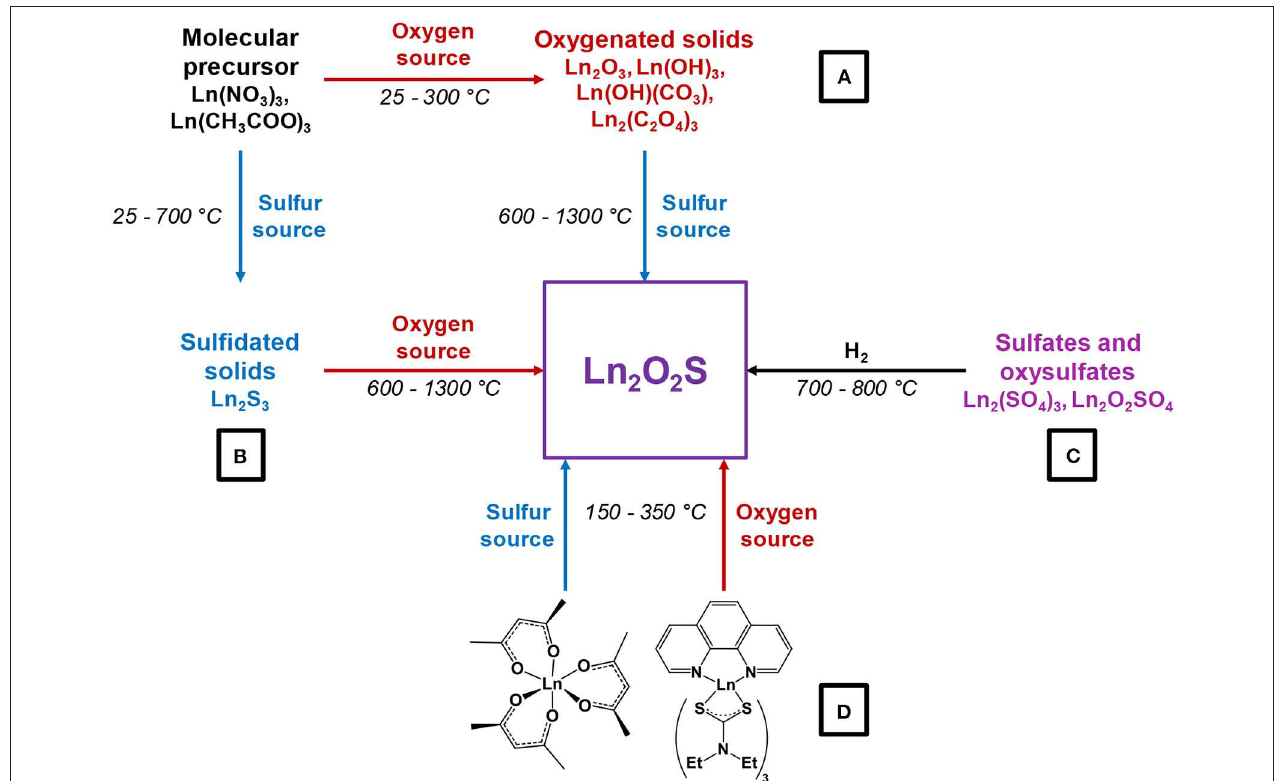
FIGURE 7 | Synthetic strategies toward Ln 2 O 2